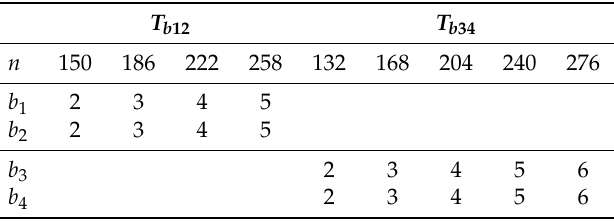
Table 6. IPR fullerene graphs with caps of type b